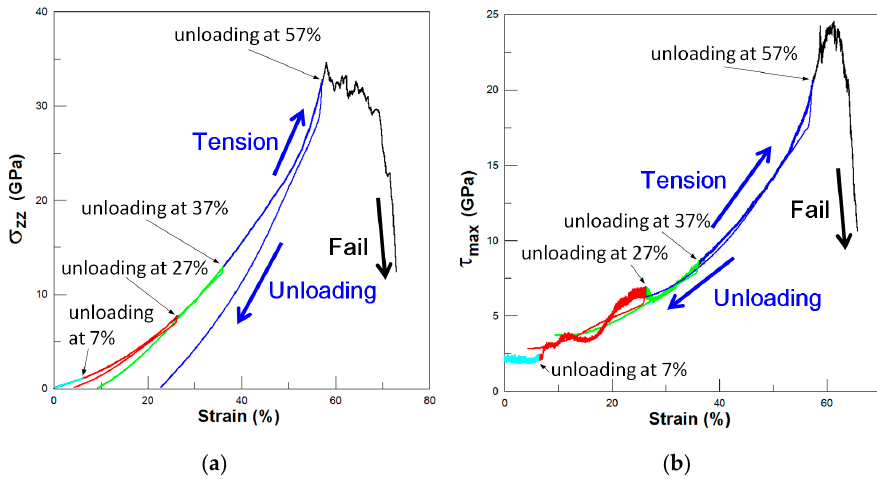
Figure 15. ( a ) Axial stress-strain curves; ( b ) maximum shear stress-strain curves (unloading at strain of 7%: cyan; 27%: red; 37%: green; 57%: blue; without unloading: black).